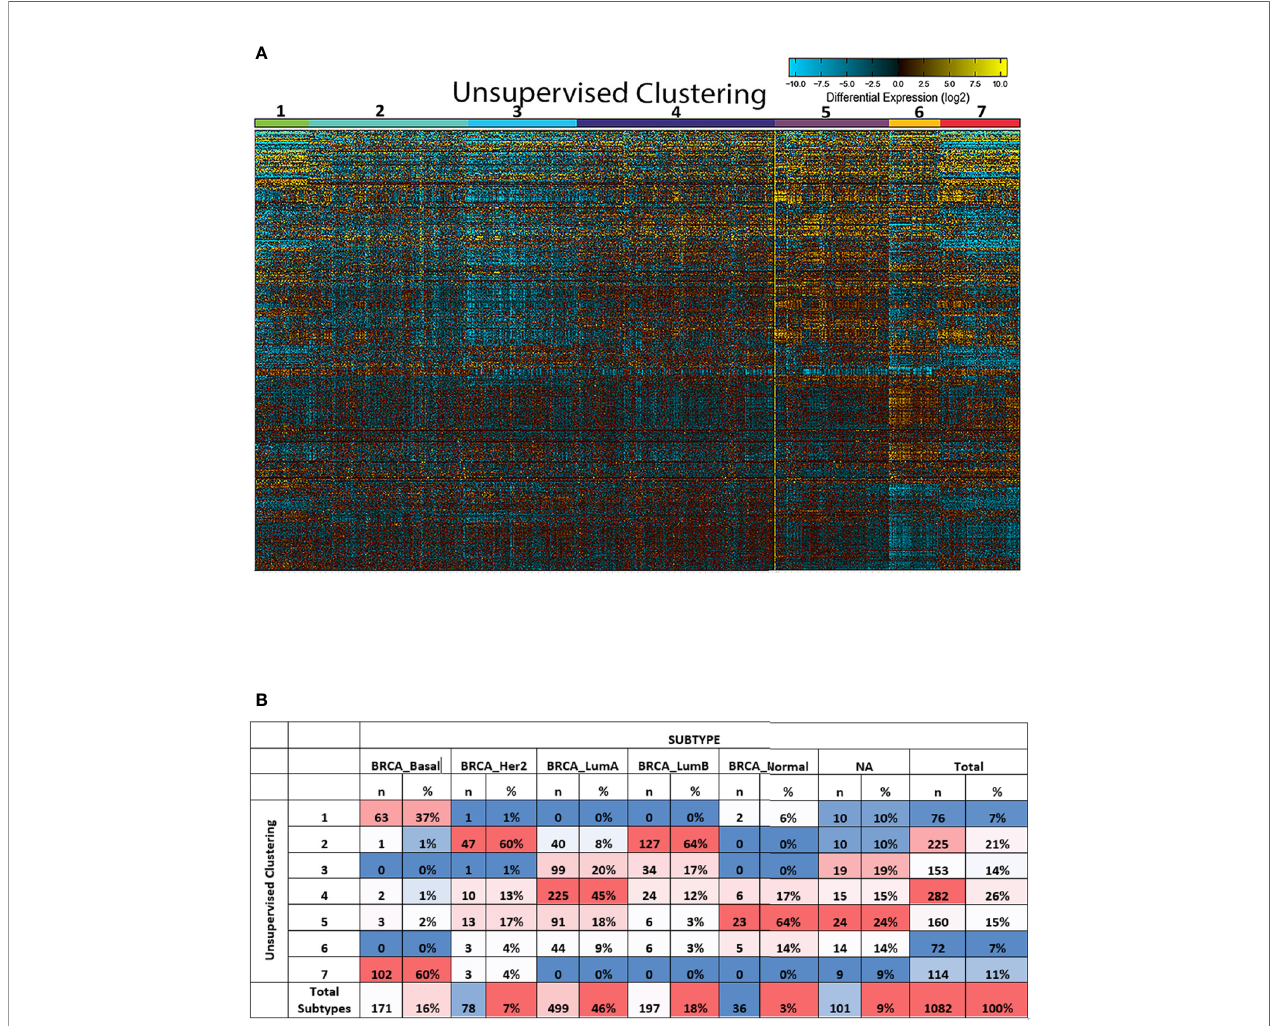
FIGURE 2 | Unsupervisedclusteringof breast cancer subtypes revealed the presence of seven distinct sub-clusters. (A) Unsupervised clusteringof the 1,084 breast cancer samples obtained fromTCGA usingICGS2 option in the AltAnalyzetool. It showed the hierarchicalcosine Euclidean option. (B) The distribution of thesevere clusters inluminal A, luminal B,and basal-likesubtypes andshowing the representative groups that match more than 50% of the total patients inthat molecular